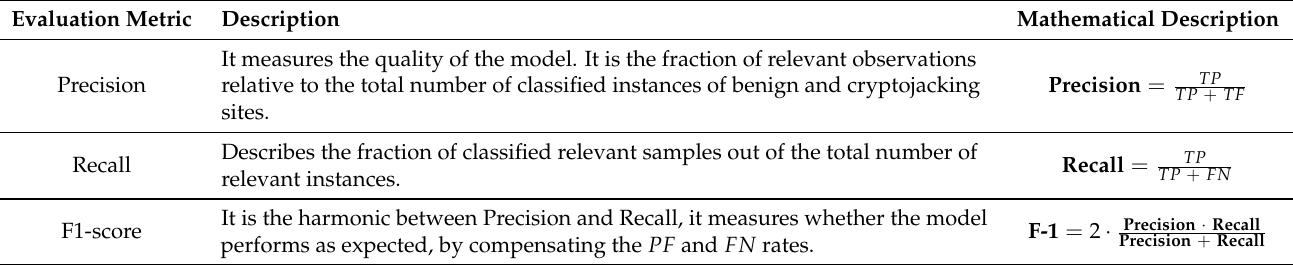
Table 6. Proposed performance metrics. It is important to note that the target class 1 is the site infected with cryptojacking, therefore TP represents the true positives and FP the false positives. Analogously, the non-target class 0 represents the benign sites, of which TN is identified as the true negatives and FN as the false negatives,